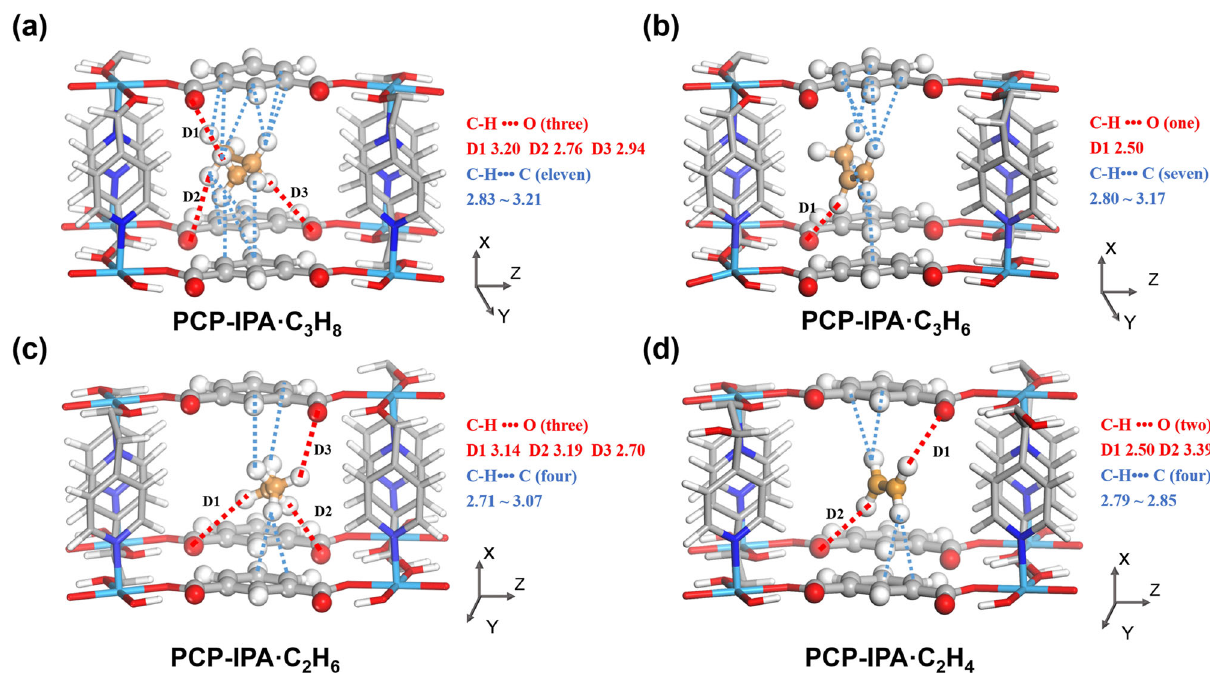
Fig. 3 | DFT-D calculated preferable binding sites for paraf fi ns and ole fi ns in PCP-IPA. a C 3 H 8 , b C 3 H 6 , c C 2 H 6 , and d C 2 H 4 binding sites in PCP-IPA. The closest contacts between framework atoms and the gas molecules are de fi ned by the